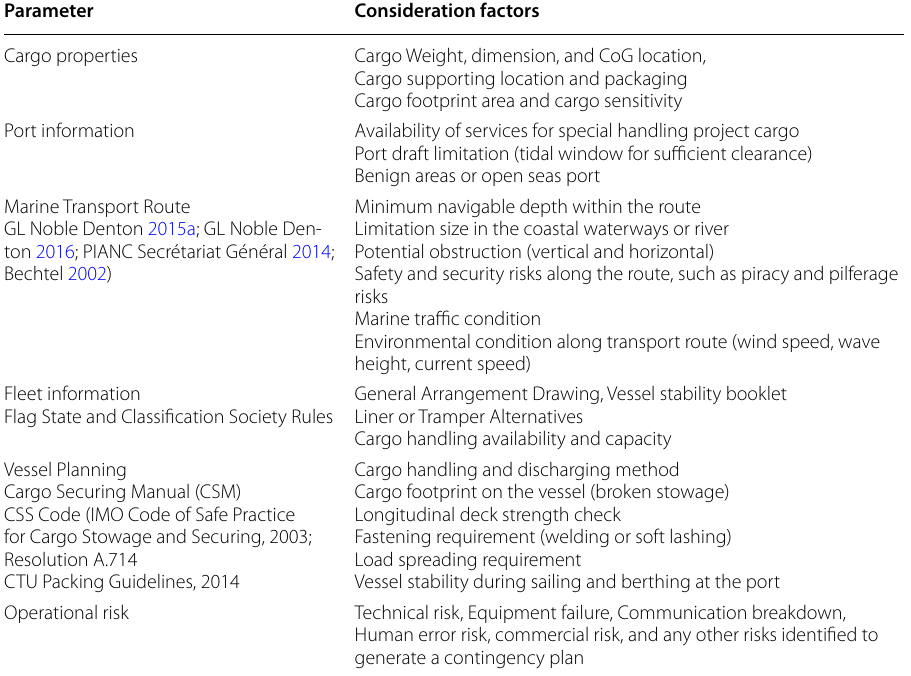
Table 4 Marine transportation consideration factors (Author’s compilation)